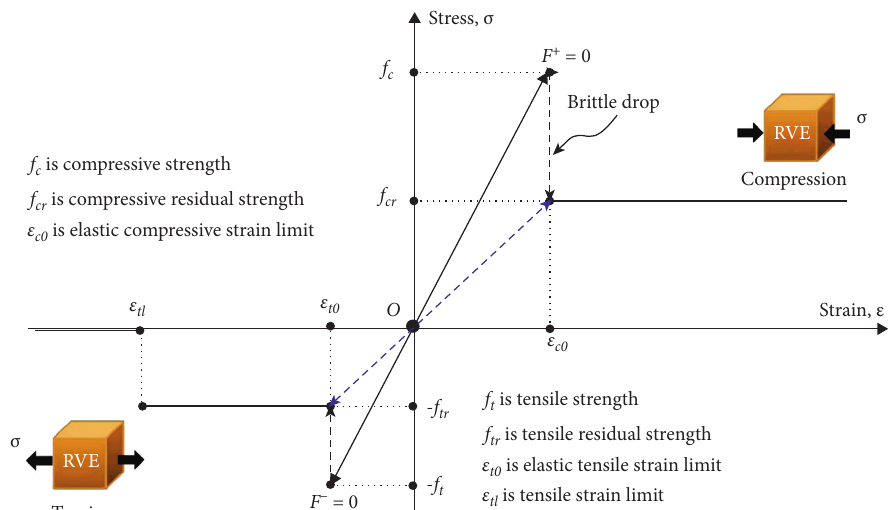
Figure 4: Constitutive association of elastic damage of